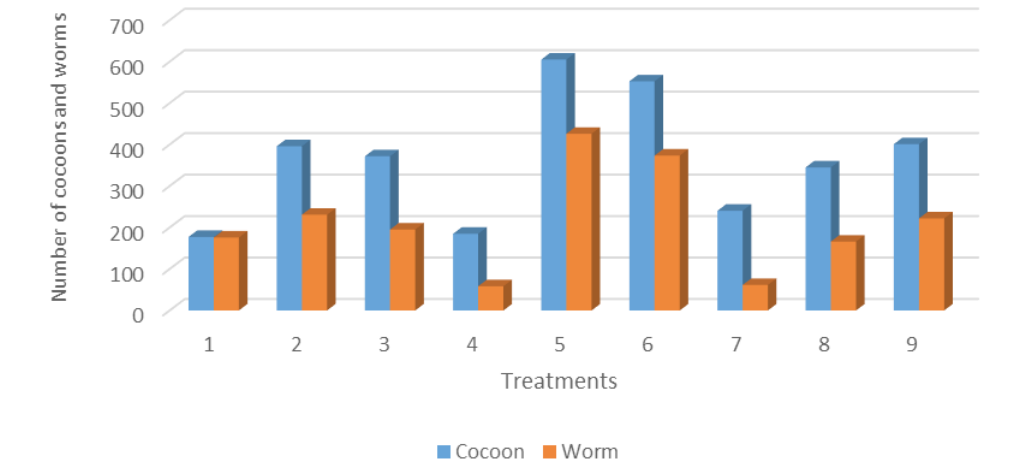
Figure 1. Comparing the number of cocoons and worms generated at the end of the vermicompost production process in 9 different substrate combinations and control sample